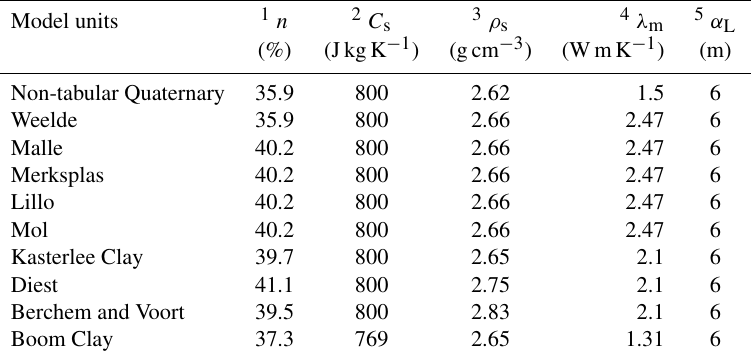
Table 3. Overview of the hydrogeological unit properties used for the updated version of the NAM heat transport model in MT3D-USGS parameter names, where 1 n is the porosity, 2 C s is the specific heat capacity, 3 ρ s is the density of the solid phase, 4 λ m is the thermal conductivity, and 5 α L is the